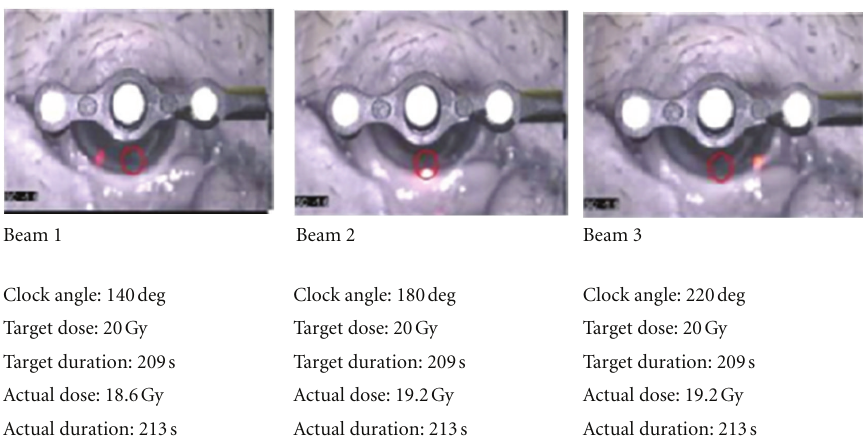
Figure 1: The figure demonstrates the beam positions on the sclera of the animal’s right eye. Each beam passes through the area of the porcine eye akin to the human pars plana. A 60Gy dose was delivered in this